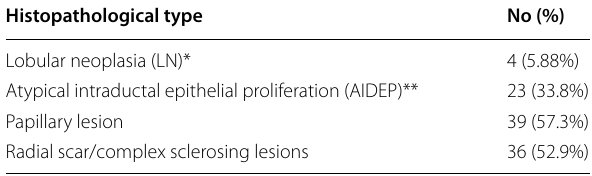
*Lobular neoplasia (LN) including both atypical lobular hyperplasia (ALH) and lobular carcinoma in situ (LCIS), **Atypical intraductal epithelial proliferation (AIDEP), comprising atypical ductal hyperplasia (ADH) and flat epithelial atypia (FEA)